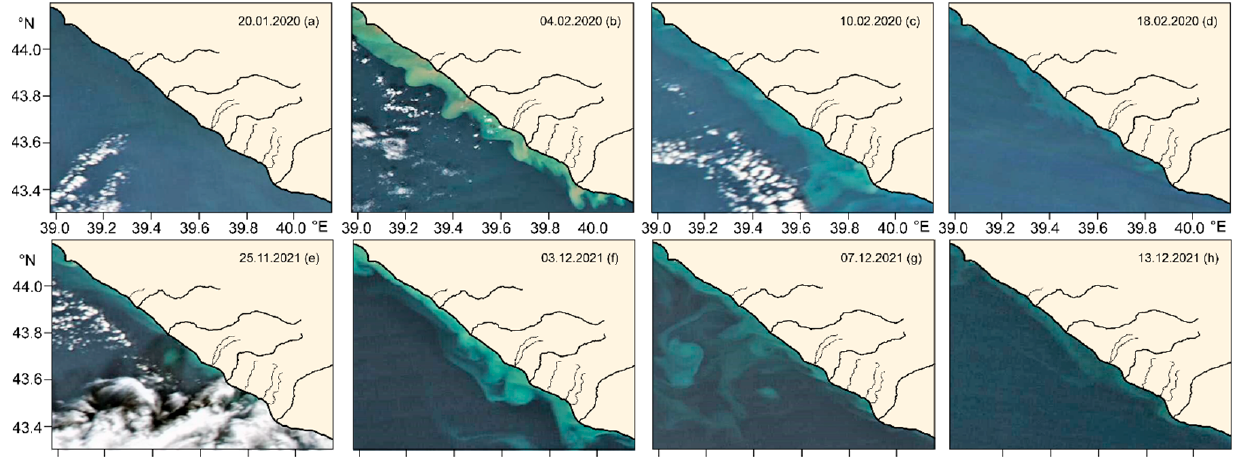
Figure 5. MODIS satellite images (visible band) of the study area demonstrating the considered river plumes on 20 January ( a ), 4 February ( b ), 10 February ( c ), 18 February ( d ) 2020 and 11 November ( e ), 3 December ( f ), 7 December ( g ), 13 December ( h ) 2021.